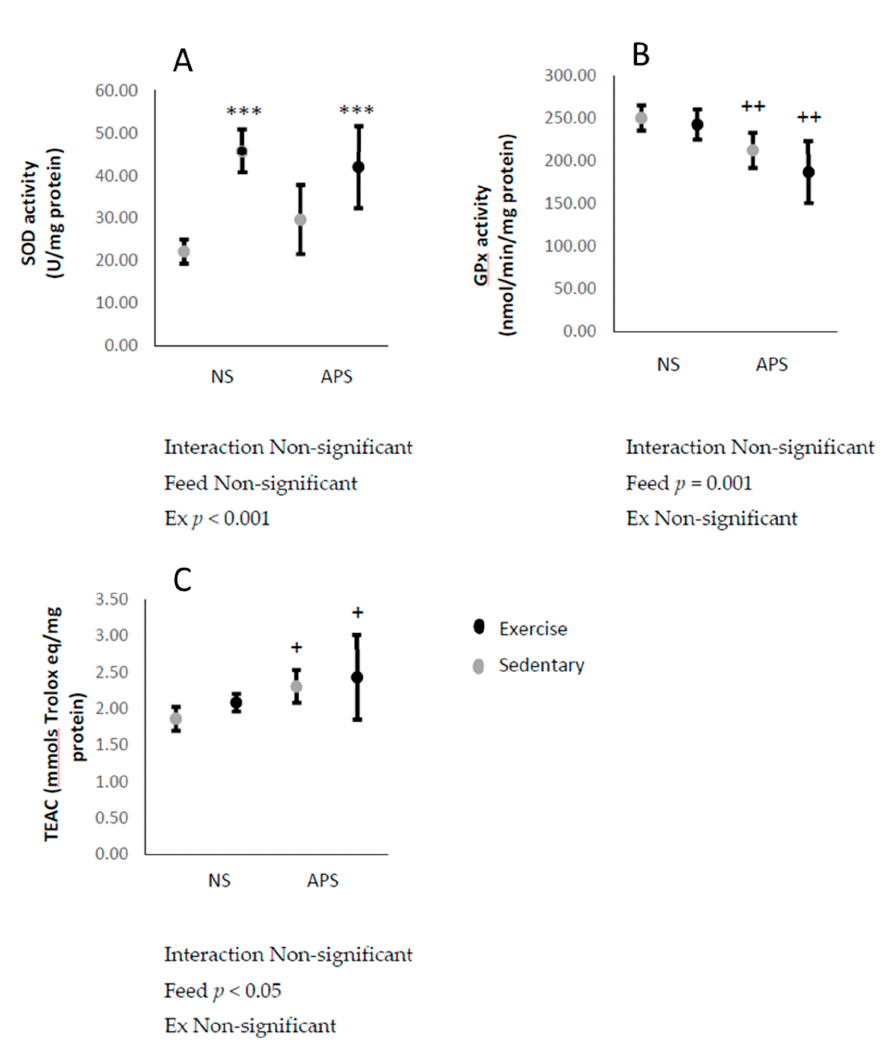
Figure 3. Means ± SEM: ( A ) liver superoxide dismutase (SOD) (control, n = 5; APS, n = 7; Ex, n = 5; Ex + APS, n = 6), ( B ) glutathione peroxidase (GPx) (control, n = 6; APS, n = 7; Ex, n = 6; Ex + APS, n = 6), and ( C ) Trolox equivalent antioxidant capacity (TEAC) (control, n = 6; APS, n = 7; Ex, n = 6; Ex + APS, n